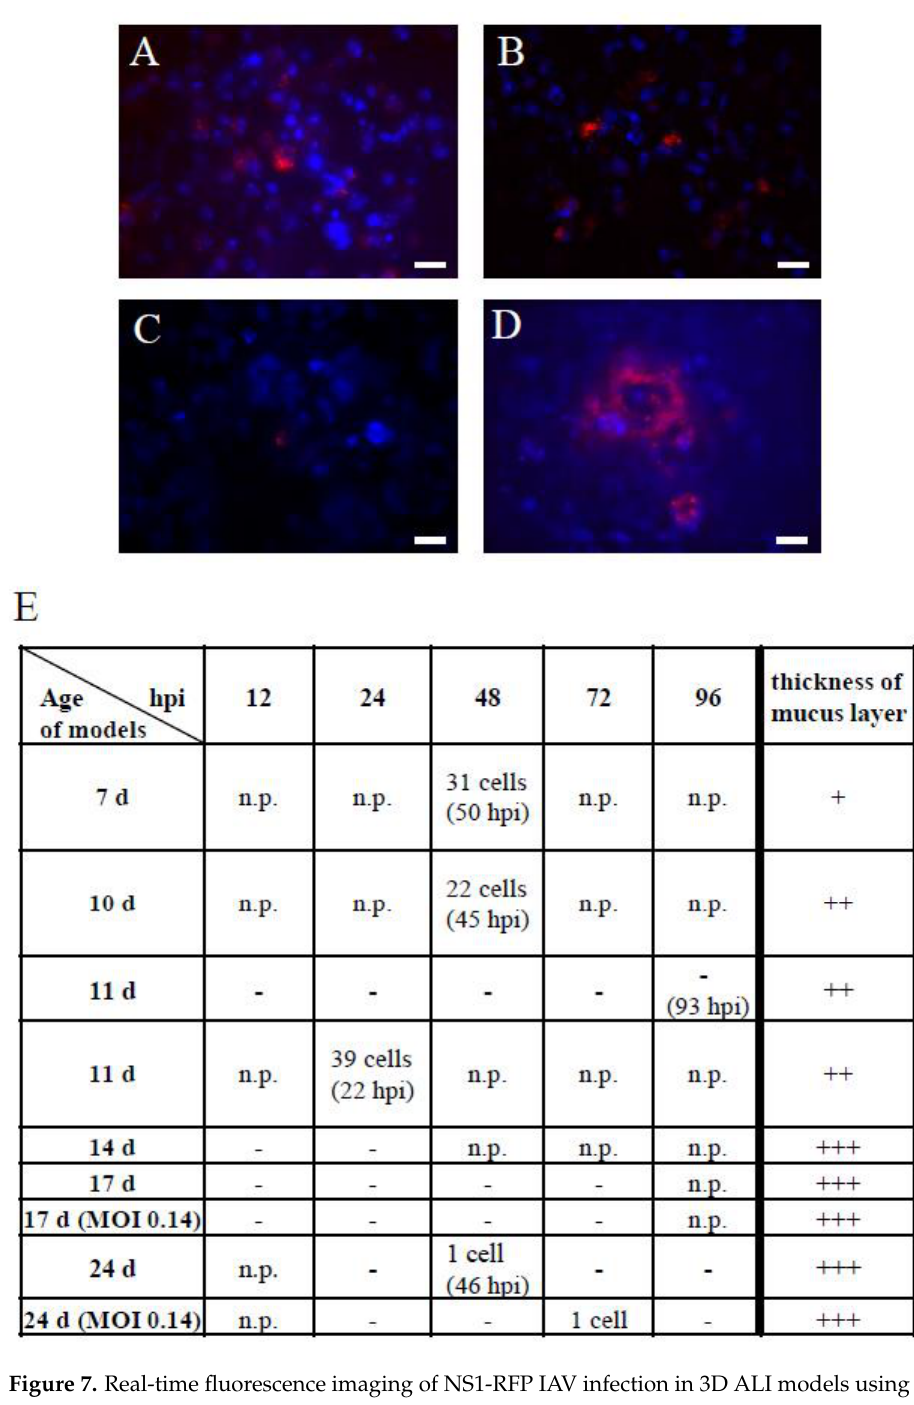
Figure 7. Real-time fluorescence imaging of NS1-RFP IAV infection in 3D ALI models using an MOI of 0.01. ( A ) 7 day old ALI model at 50 hpi, ( B ) 10 day old ALI model at 45 hpi, and ( C ) 24 day old ALI model at 46 hpi showed NS1-RFP fluorescence in detached cells. ( D ) 11 day old ALI model at 22 hpi showing NS1-RFP fluorescence in an attached cell cluster. Scale bars represent 20 µm. ( E ) Overview of the analysis of 3D ALI models with different cultivation times (age of models in days) over a period of 12 to 96 hpi. The models were infected using an MOI of 0.01, with two exceptions using an MOI of 0.14 as noted in the column “age of models”. In the table, the number of NS1-RFP-positive cells found in the entire respective ALI model is indicated. With the increasing age of the models, the thickness of the mucus layer rose, which was histologically estimated from alcian blue stainings of the respective cultivation day (+ = low amount, ++ = medium amount, +++ = high amount). n.p. = not performed, - = no fluorescence